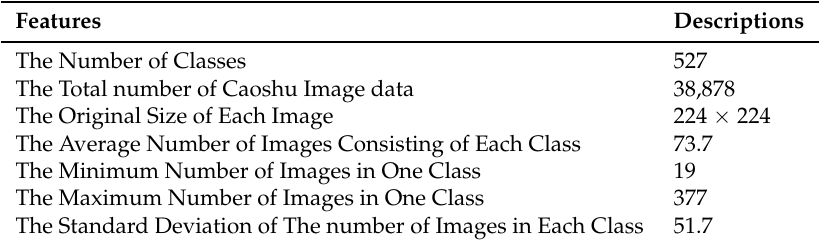
Table 4. The detailed information of our self-made Caoshu